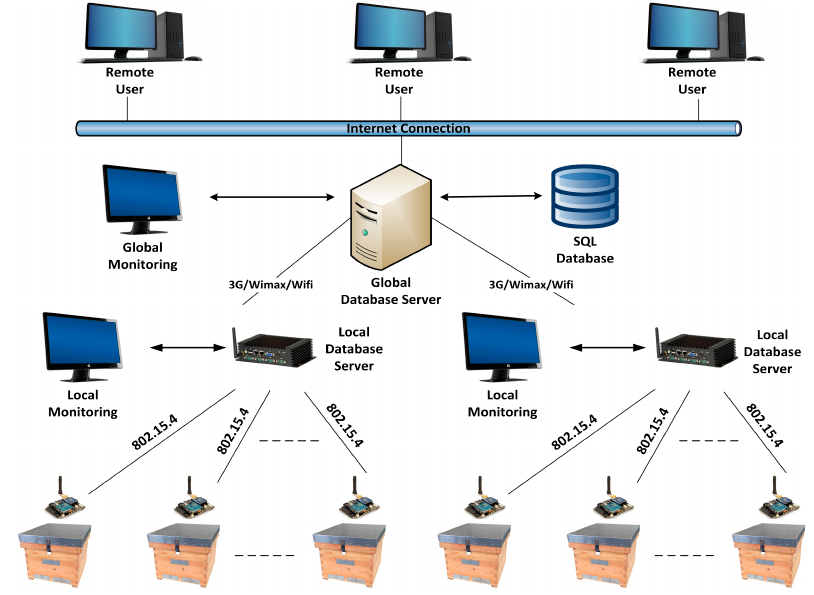
Figure 1. Architecture of the WBee system.